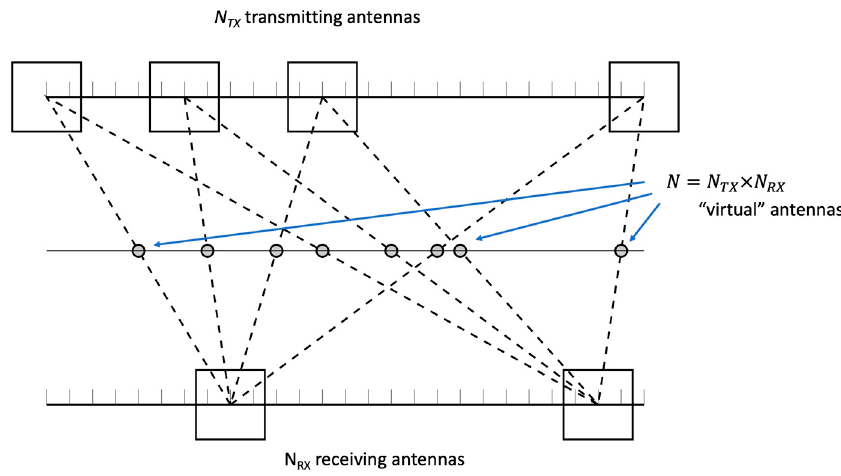
Figure 15. MIMO working principle, N TX transmitting antennas with N RX receiving antennas are equivalent to N TX × N RX “virtual” antennas.